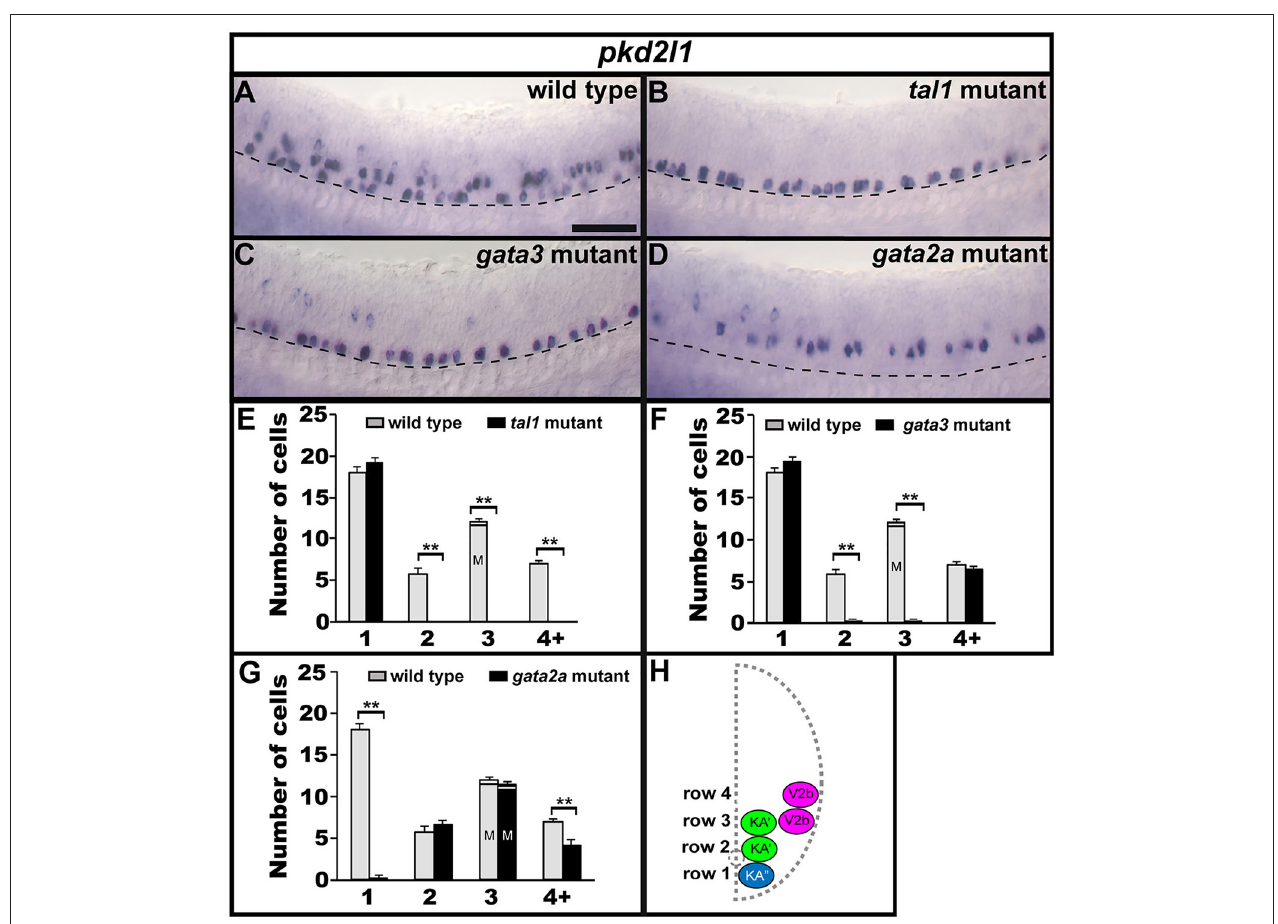
FIGURE 8 | Expression of pkd2l1 in tal1 , gata3, and gata2a mutants. Lateral views of pkd2l1 expression in 24h WT sibling (A) and tal1 (B) , gata3 (C) , and gata2a (D) mutants. Dorsal, top; anterior, left. Scale bar = 50 microns. Dashed lines indicate ventral limit of spinal cord. The approximate proportions of medial and lateral row 3 cells are indicated by horizontal lines separating the number of medially-located cells (bottom and indicated with an “M”) from the number of laterally-located cells (top and indicated with a “L”). Mean number of cells expressing pkd2l1 in each D/V row of spinal cord region adjacent to somites 6–10 in WT and mutant embryos (E–G) . All counts are an average of at least 4 embryos. Error bars indicate SEM. Statistically significant comparisons are indicated with brackets and stars. ** P < 0.01. For P- values see Supplementary Table 3. Cross-sectional schematic indicating positions of KA ′′ , KA ′ , and V2b neurons (H) .